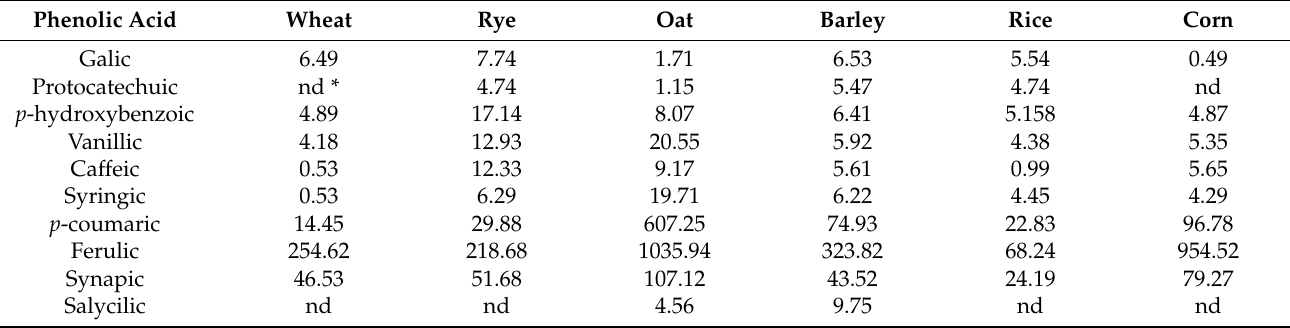
Table 2. Average values of phenolic acid content in different cereal grains ( µ g/g)